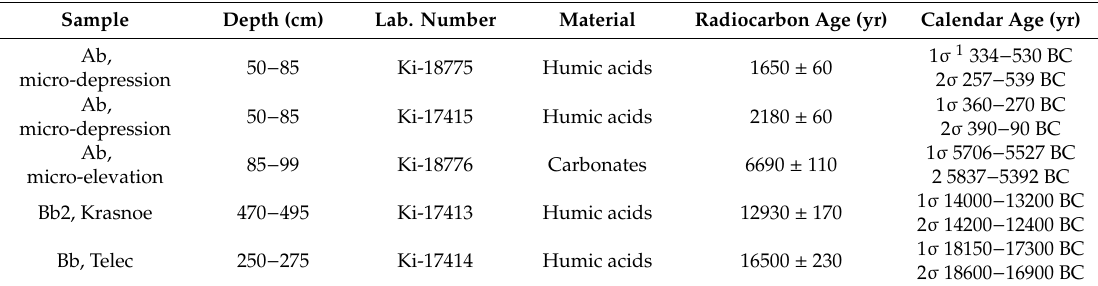
Table 1. Radiocarbon data for paleosols of Bryansk region.